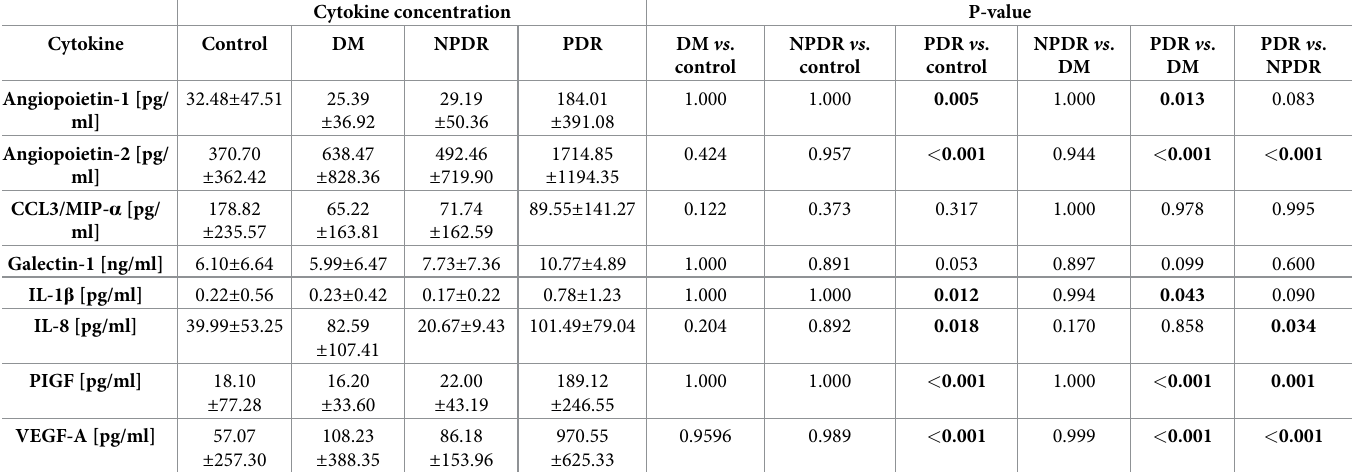
Table 3. Cytokine concentration (mean ± SEM) in vitreous samples of control, diabetes mellitus (DM), non-proliferative diabetic retinopathy (NPDR) patients, and proliferative diabetic retinopathy (PDR) patients measured via ELISA. Significant p-values are in